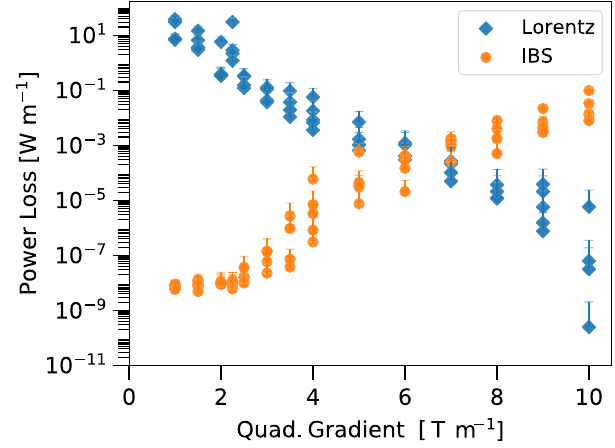
FIG. 9. Dependence of IBST and Lorentz stripping (quadru- poles only) on field gradient for the same lattice and optimization scheme as Fig.